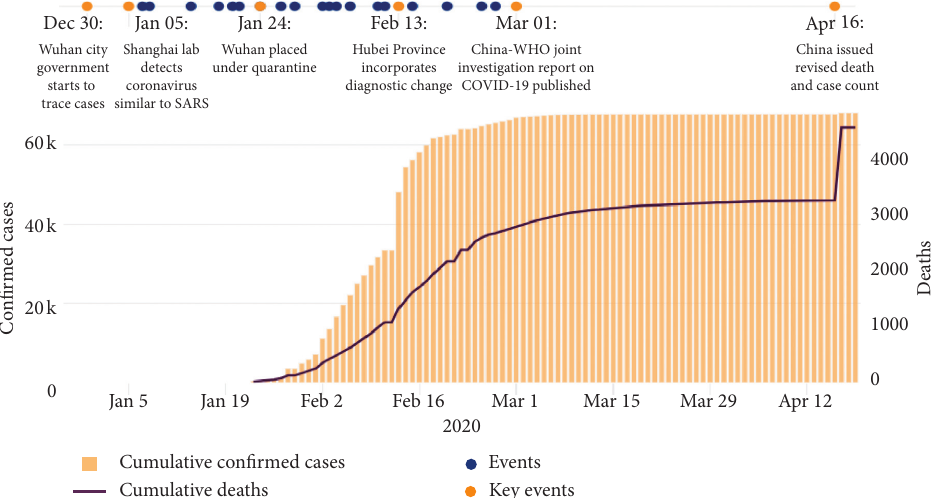
Figure 17: Accumulated timetable for confirmed cases in Hubei Province (https://coronavirus.jhu.edu/map.html).